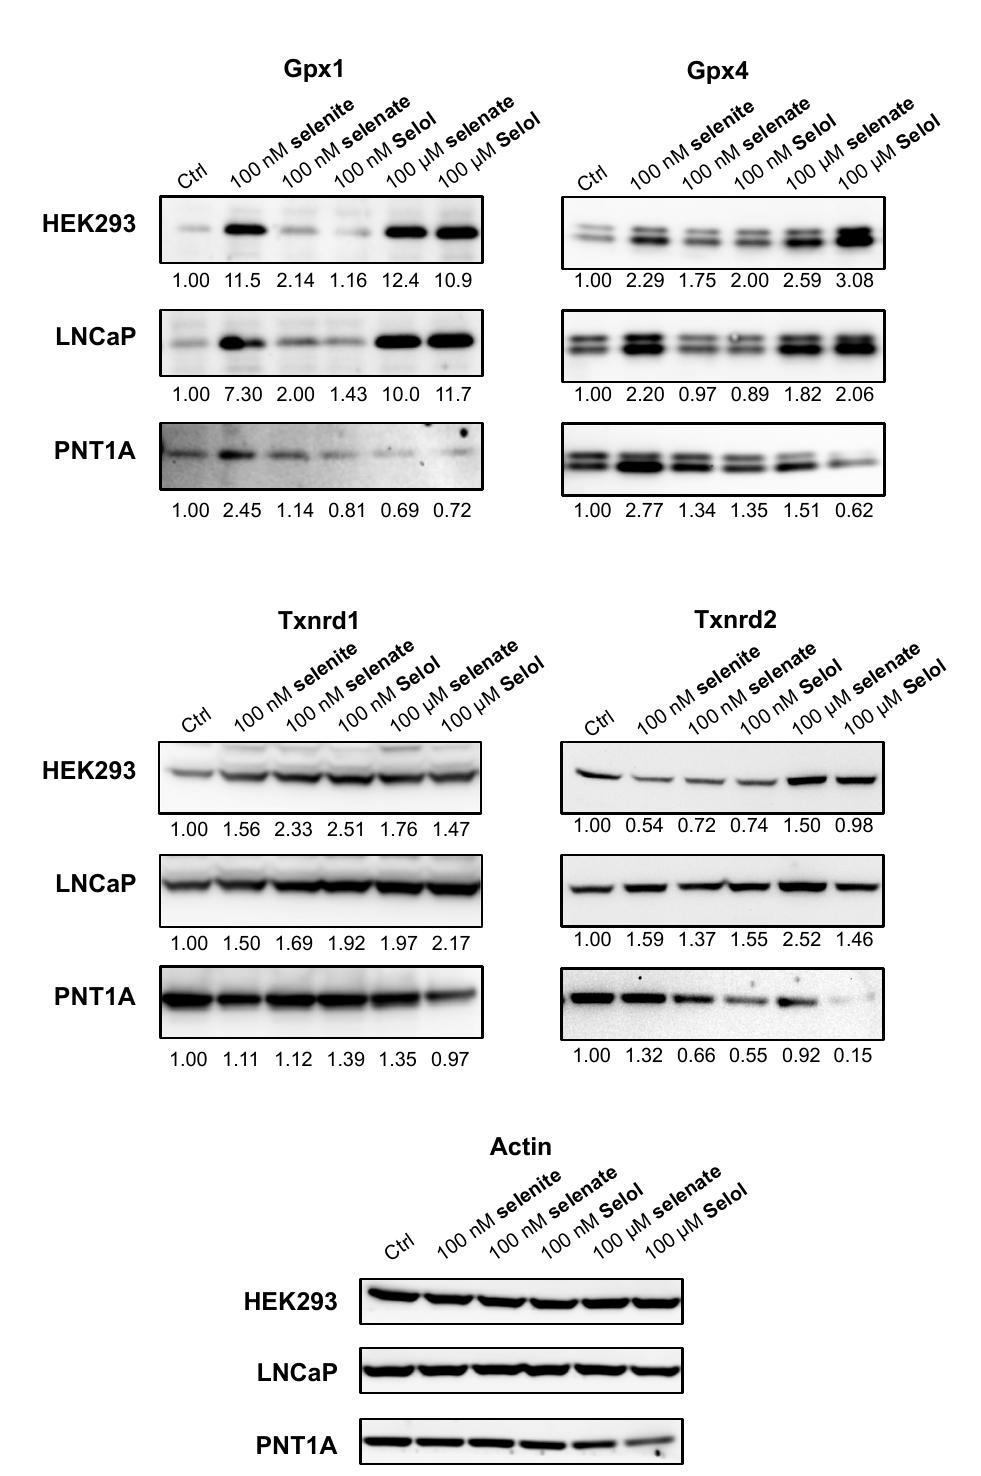
Figure 6. Analysis of selenoprotein regulation by selenite, selenate or Selol supplementation in di ff erent cell lines. HEK293, LNCaP and PNT1A cells were grown with Ctrl medium supplemented with either 100 nM or 100 µ M of di ff erent selenium sources. Cellular extracts were analyzed for selenoprotein expression by western blots using specific antibodies. Protein levels were normalized over Actin levels and expressed relative to the Ctrl condition (no added selenium), set as 1.